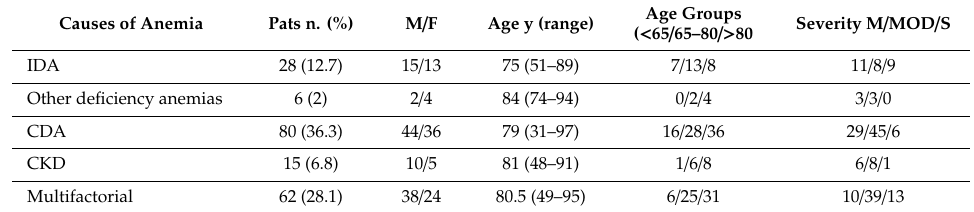
Table 2. Main general characteristic of our 191 patients stratified by diagnosed causes of anemias. Causes of Anemia Pats n. (%)